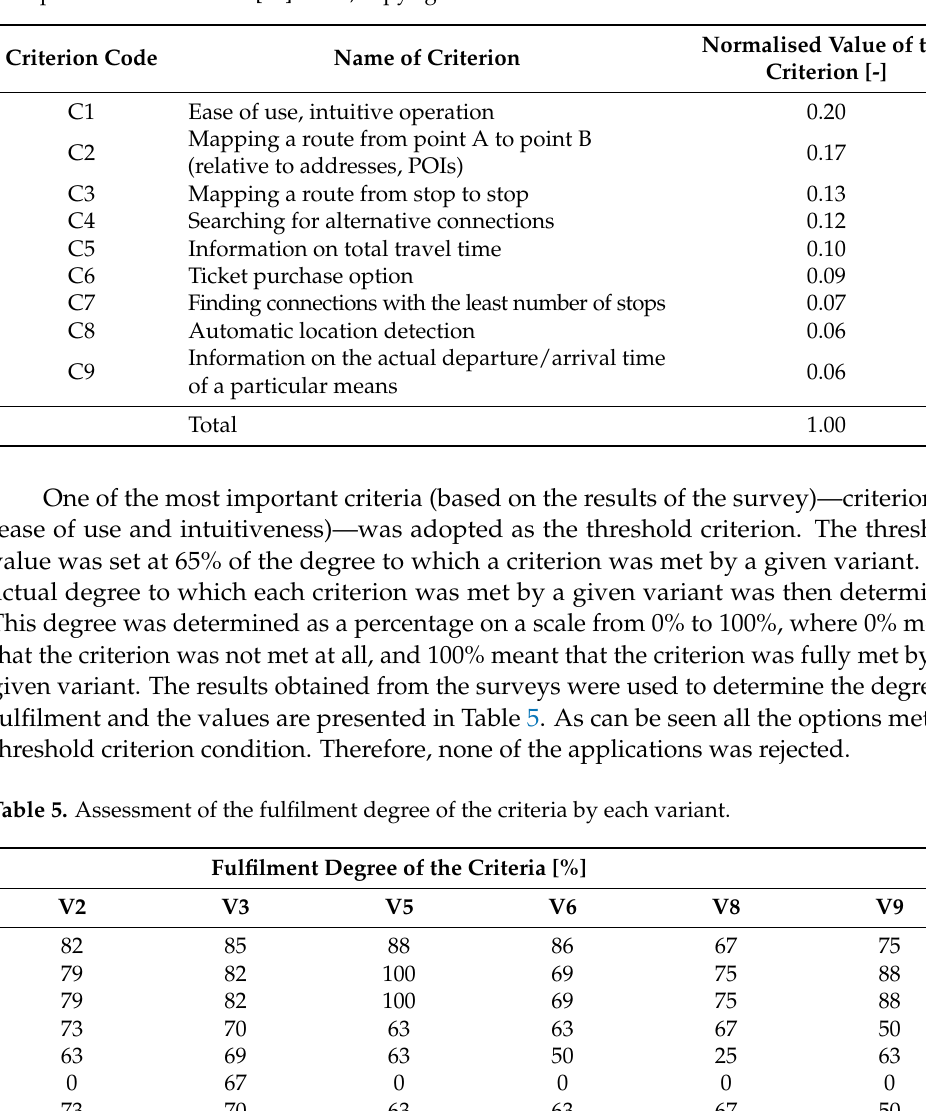
Table 4. Criteria for the assessment of variants to be considered for ranking of the apps [Adapted with permission from Ref. [31]. 2020, copyright Cholewa.